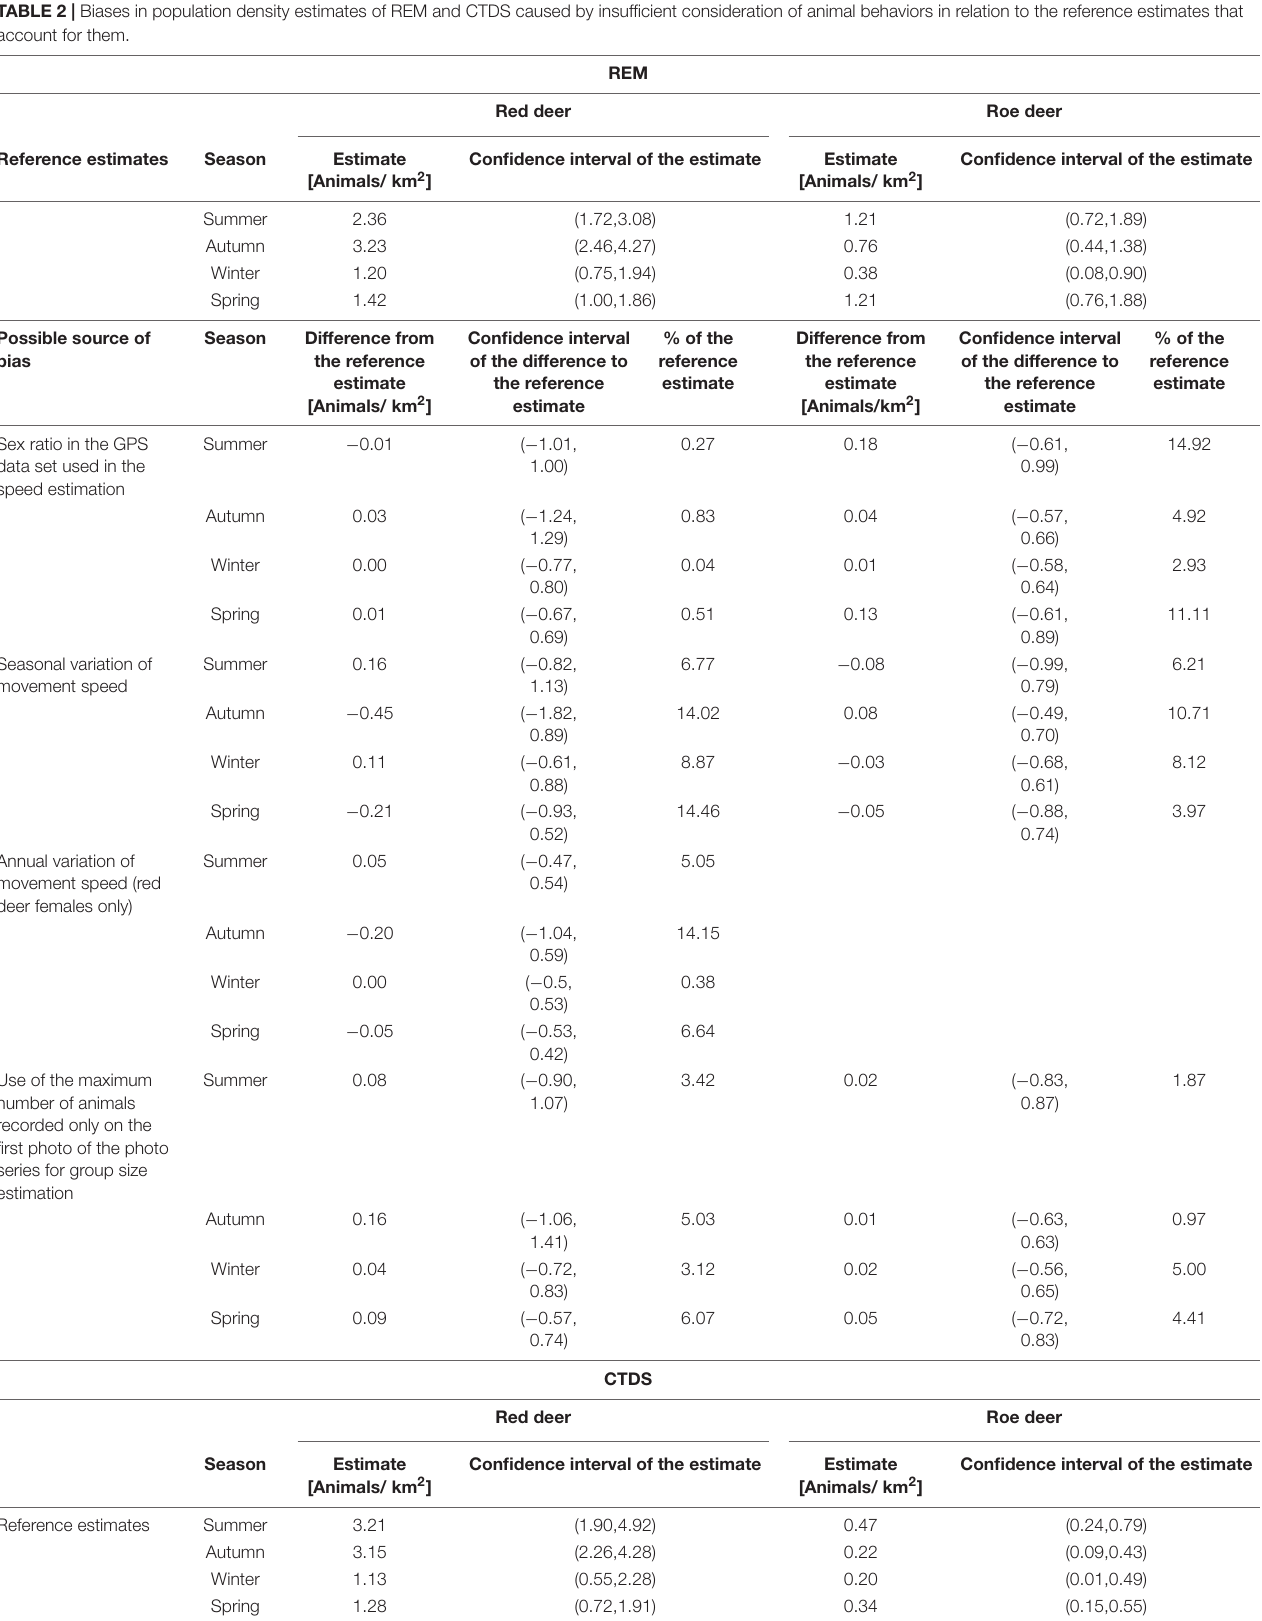
TABLE 2 | Biases in population density estimates of REM and CTDS caused by insufficient consideration of animal behaviors in relation to the reference estimates that account for them.